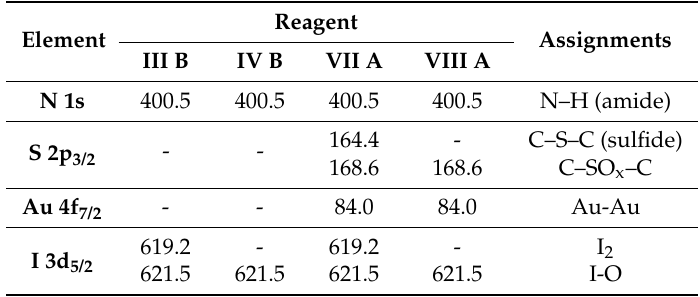
Table 1. Electron binding energies (eV) of the showed element for the XPS analyzed III B , IV B , VII A and VIII A compounds.